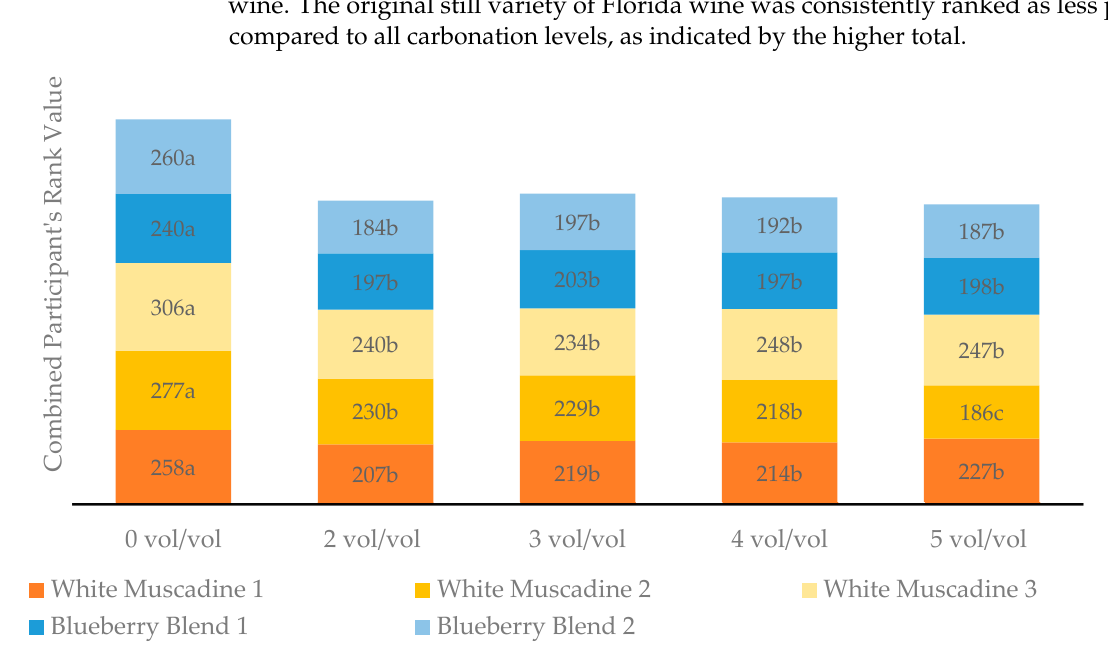
Figure 1. The preference rank sums for all five carbonation levels for all five Florida wines. Letter (a, b, c) denotes statistical significance ( p < 0.05) between wine carbonation levels using Friedman analysis of rank and Tukey’s HSD statistical tests.